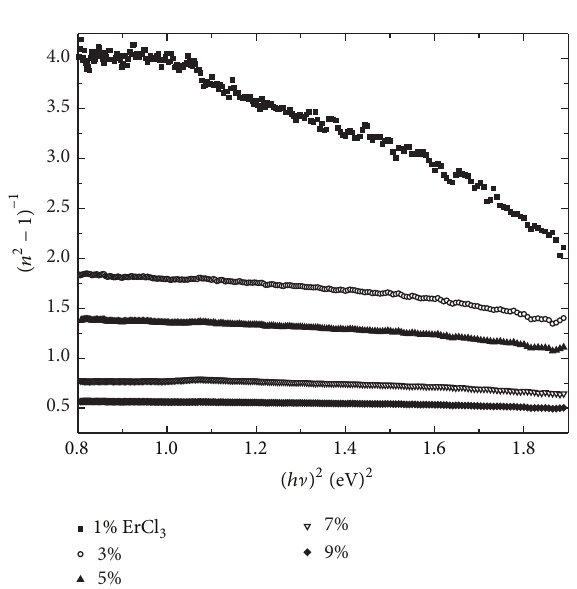
Figure 8: Relation between the refractive index and the wavelength for PVA :ErCl 3 .